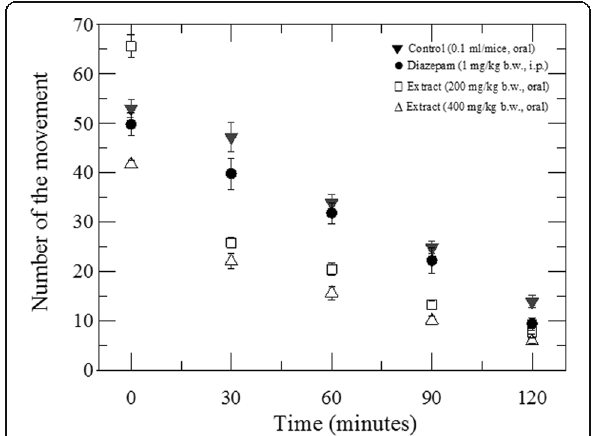
Fig. 1 Effect of the ethyl acetate extract of D. malabarica seeds in open field test